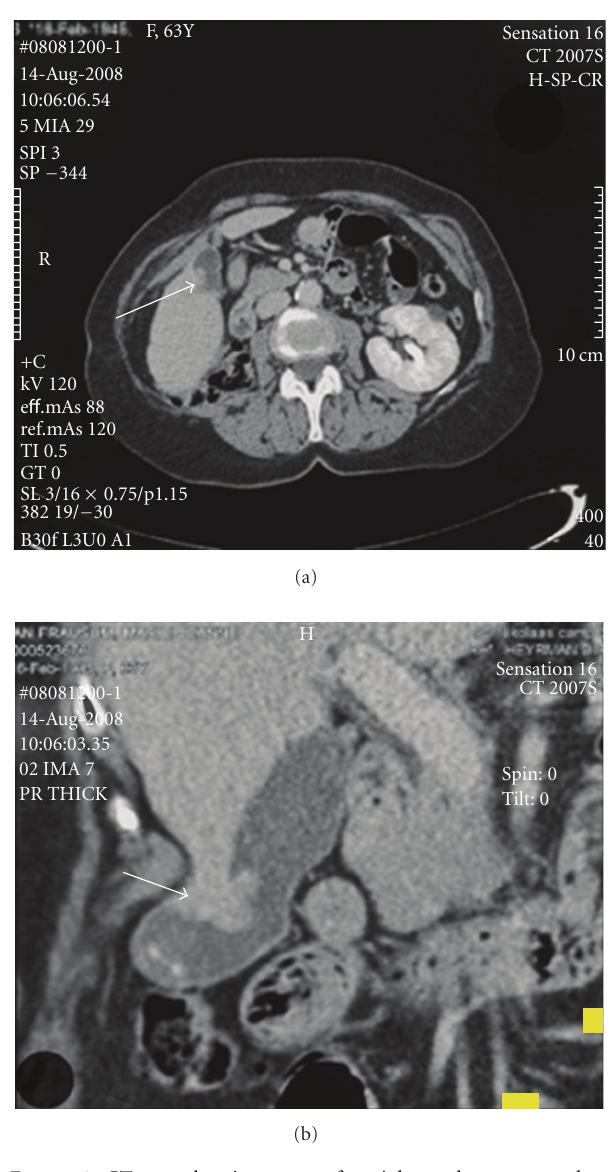
Figure 3: CT scan showing status after right nephrectomy and an evolutive papillary lesion in the gallbladder of approximately 1.9 cm ((a) and (b), arrows). (b) Contains the coronal reconstruction.